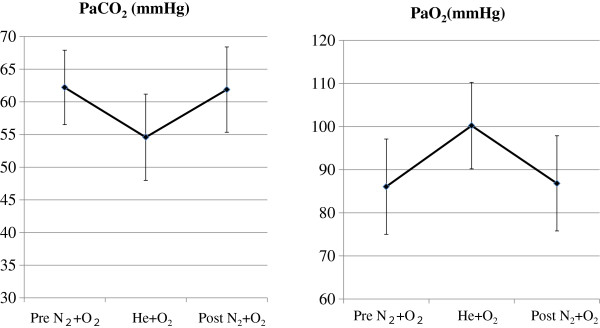
PaCO2 and PaO2 under TGI. The gas mixture under TGI was changed from nitrogen-oxygen to helium-oxygen and back.